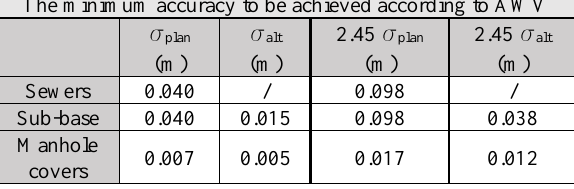
Table 2. the minimum accuracy to be achieved according to AWV.